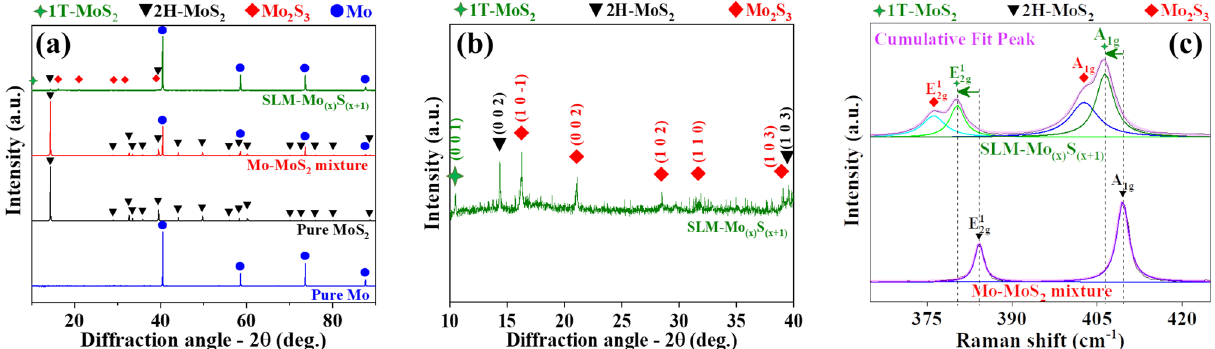
Figure 3. (a) XRD patterns of the pure Mo powder, MoS 2 powder, Mo-MoS 2 powder mixture, and SLM- Mo (x) S (x+1) samples, (b) magnified XRD peaks between 10 ≤ 2 ϴ ≤ 40 showing the presence of 1T-MoS 2 , 2H-MoS 2 , and Mo